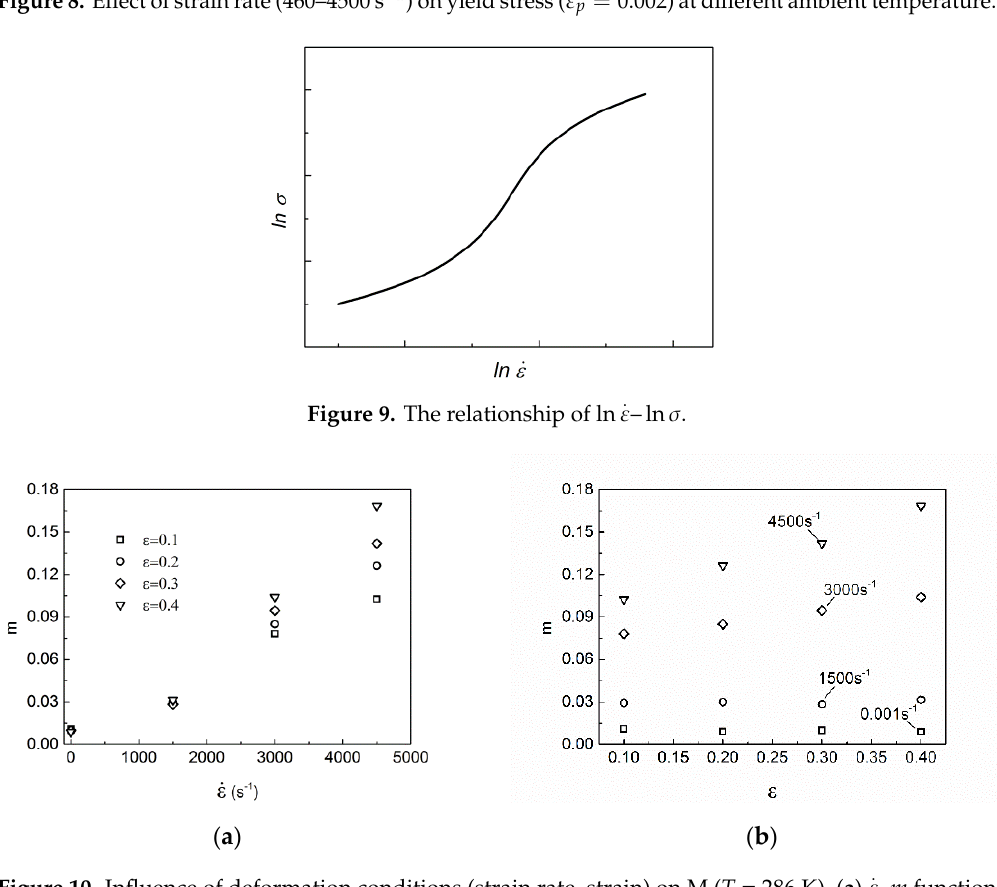
Figure 10. Influence of deformation conditions (strain rate, strain) on M ( T = 286 K), ( a ) 𝜀̇–𝑚 function relation, ( b ) 𝜀–𝑚 function relation.